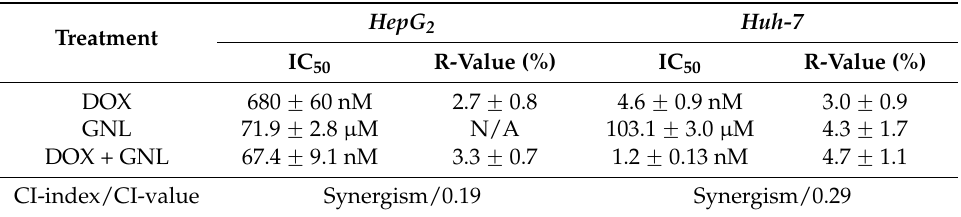
Table 2. Effect of 6-gingerol (GNL) on the cytotoxicity parameters of DOX in liver cancer cells. Treatment